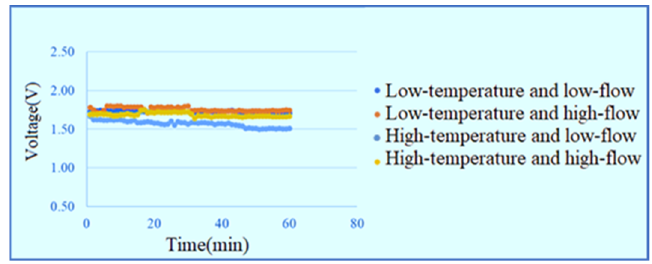
Figure 11. Voltage data at upper outlet of runner.